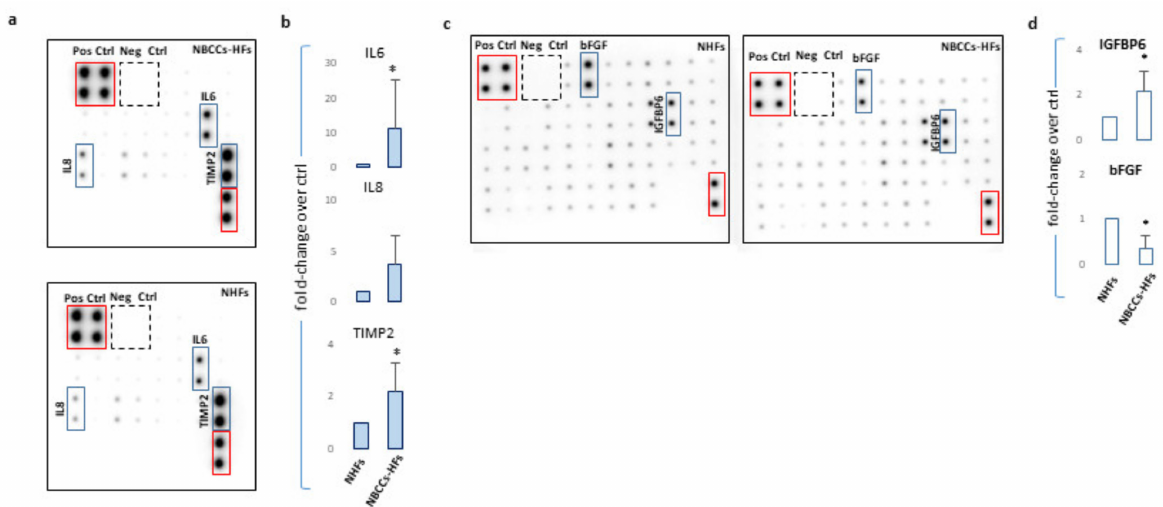
Figure 3. ( a ) One representative protein array assay comparing inflammatory factors released by NBCCS-HFs and NHFs. ( b ) Histograms report densitometric analysis of four independent experiments mean ± SD. ( c ) One representative protein array assay comparing growth factors released by NBCCS-HFs and NHFs. ( d ) Histograms report densitometric analysis of three independent experiments mean ± SD. * p ≤